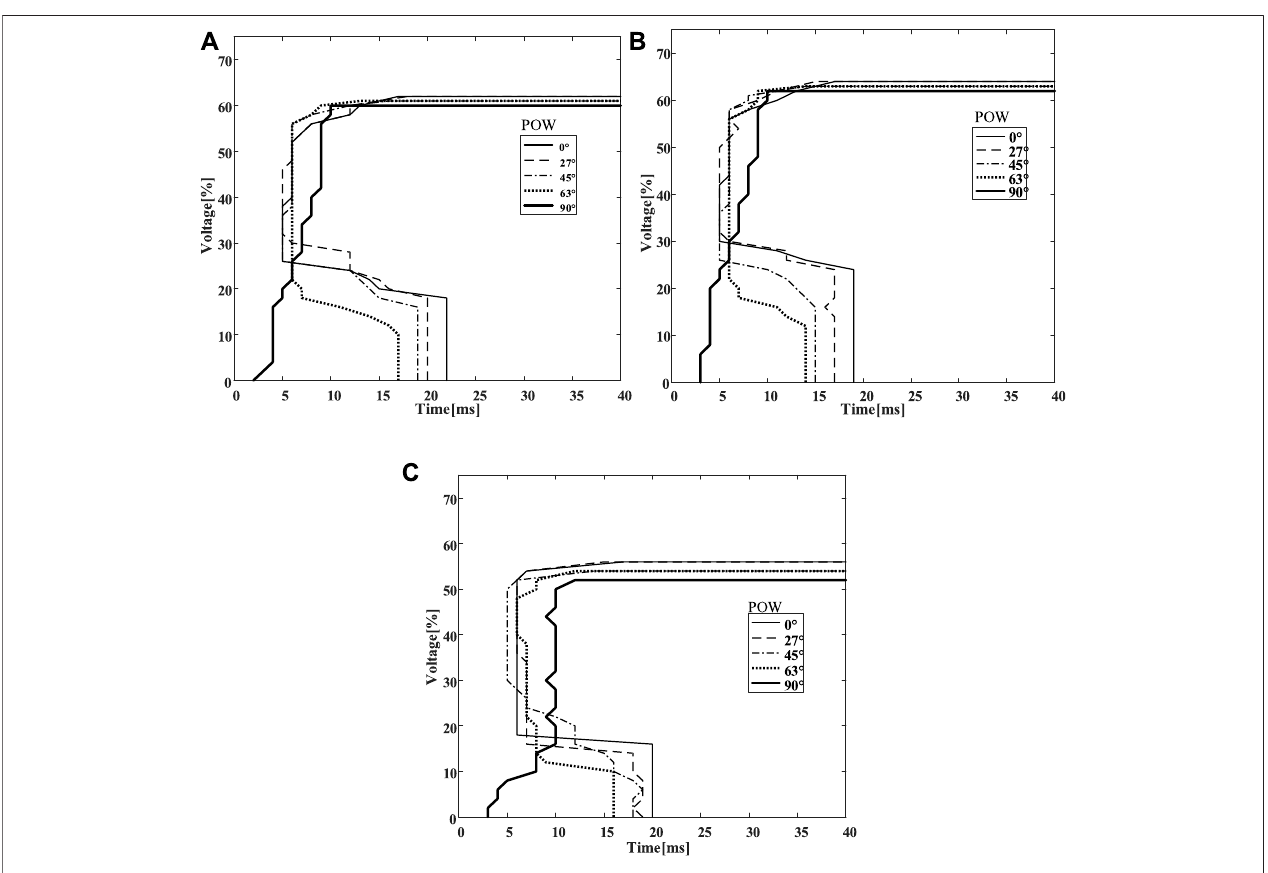
FIGURE 8 | Test results considering the different POW (0 ° PAJ). (A) Results for R1. (B) Results for R2. (C) Results for R7.